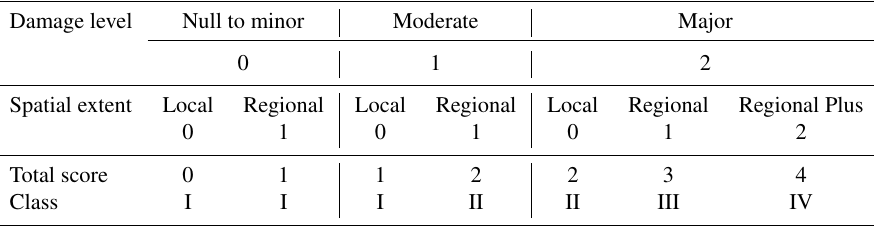
Table 3. Multi-criteria severity scale for flood events. Classification is done according to (1) the level of damage evaluated as detailed in Table 2 and (2) the spatial extent.